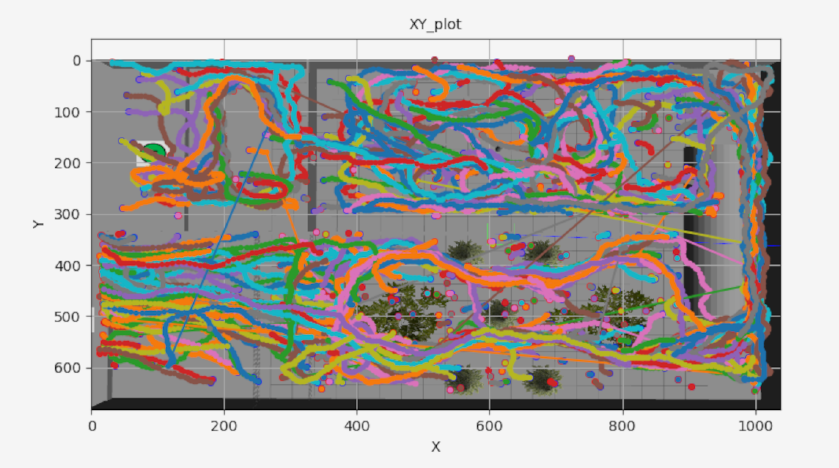
Figure 11. This diagram illustrates the navigation of UAV using untrained SCAN in the challenging environment. The top left image shows the top-view navigation trajectory of UAV projected on the top-view of the environment map.